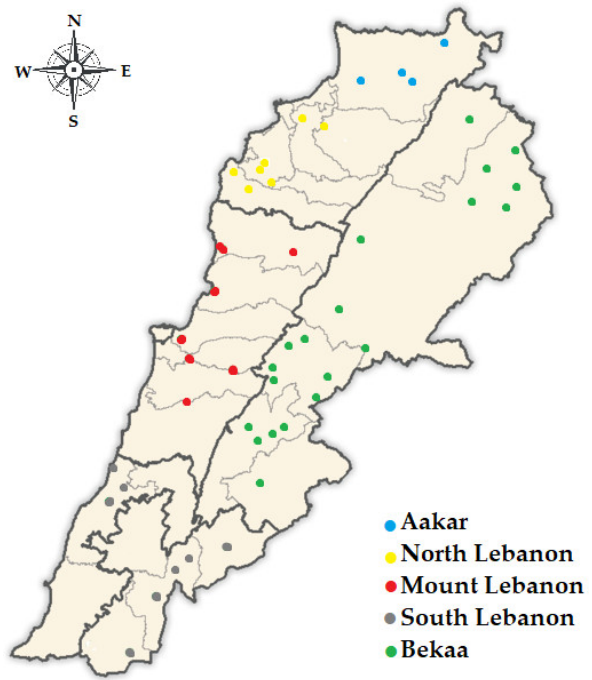
Figure 1. Geographic distribution of collection sites of the snake melon seeds landraces. Table 1. Details of collected Lebanese snake melon accessions used in this